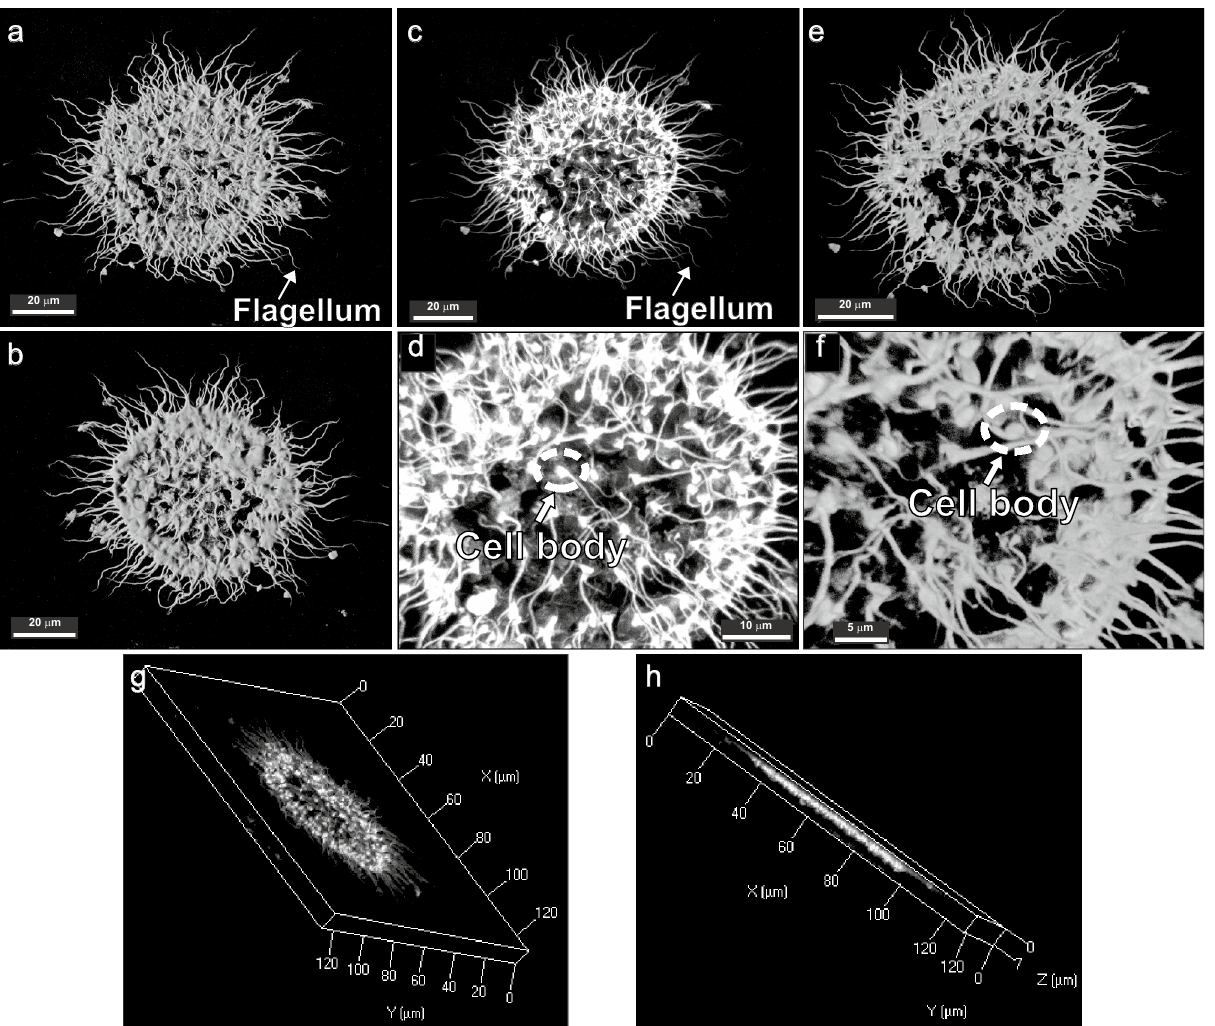
Figure 2. Confocal laser scanning microscopy photomicrographs of colonial choanoflagellate from the Capas Blancas Mb. ( R. cushmani Biozone) at Baños de la Hedionda, with distinguishable cell body, flagellum, and the connecting tissue between each unicellular entity. ( a ) Front view with shadow filter. ( b ) Back view with shadow filter. ( c ) Front view with maximum filter. ( d ) Detailed zoom of figure c. ( e ) Front view with transparent filter. ( f ) Detailed zoom of figure e. ( g – h ) 3D model with X, Y and Z